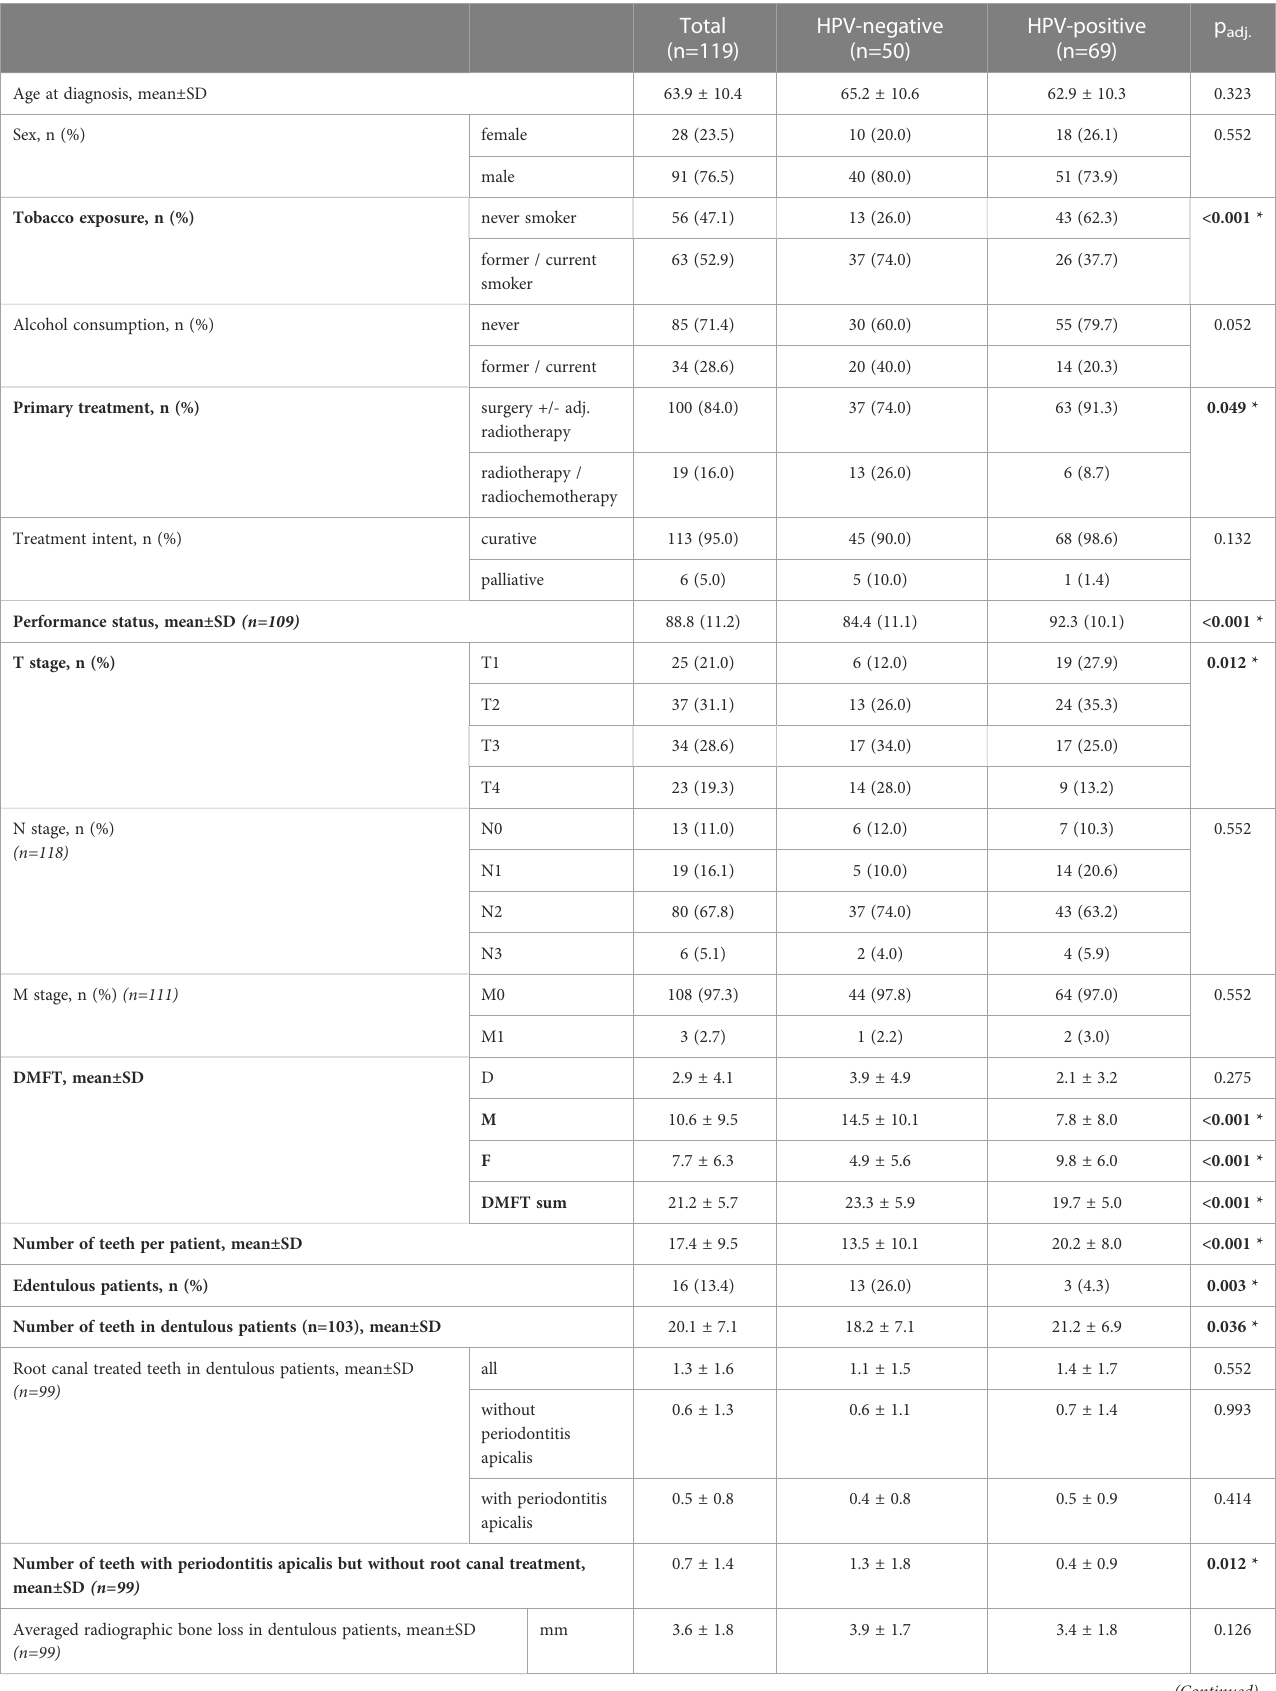
TABLE 1 Univariate comparison of patient-related risk factors for oropharyngeal squamous cell carcinoma, age, sex, primary treatment, treatment intent, tumor/node/metastasis staging, and oral health parameters between positive and negative human papillomavirus (HPV) status